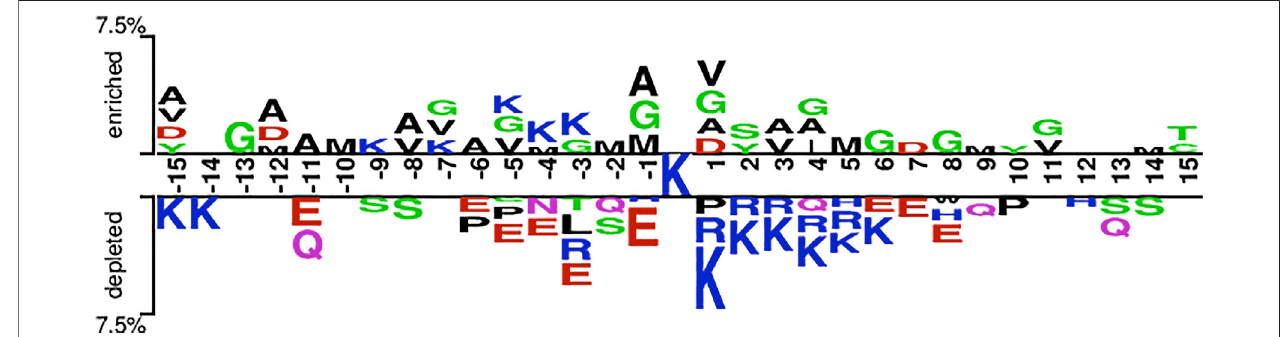
FIGURE 2 | Overall sequence pattern discrepancy between positive and native samples illustrated by Two Sample